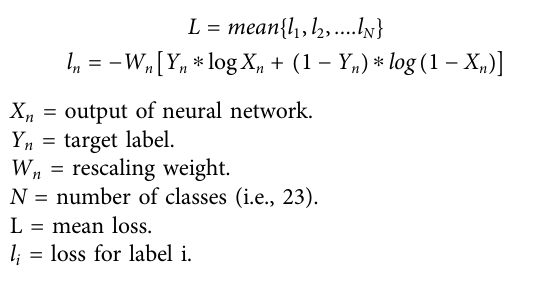
Logistic regression and USE embeddings